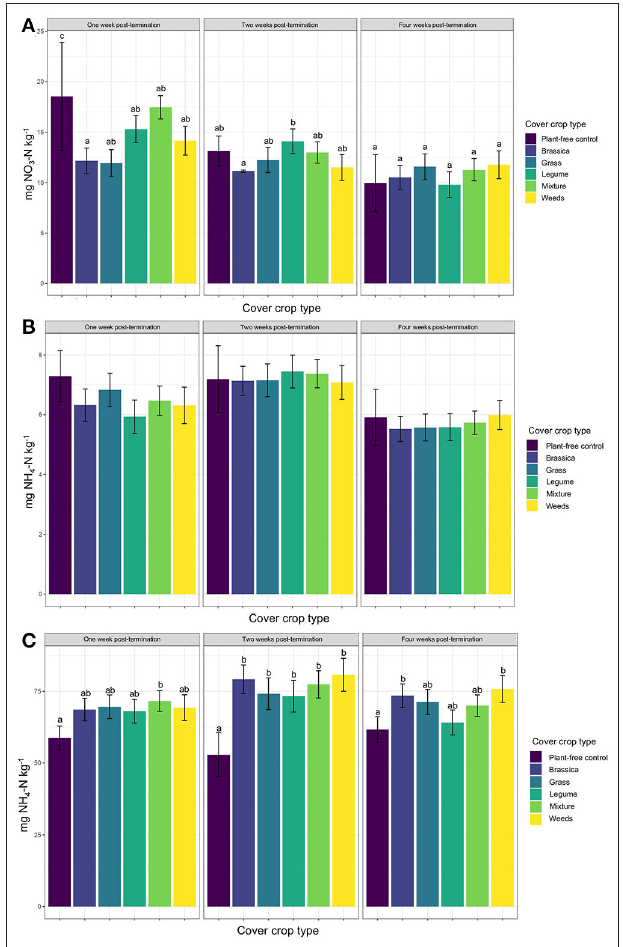
FIGURE 1 | Mean soil (A) nitrate, (B) ammonium, and (C) potentially mineralizable nitrogen (PMN) over the course of the 4 week sampling period post-cover crop termination, by cover crop type. Letters indicate significant differences from the plant-free control from Tukey’s HSB post-hoc test ( p <